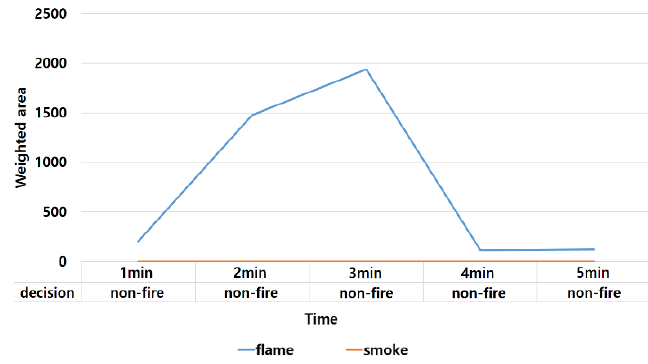
Figure 15. Sample still shots of the sunrise video clip.